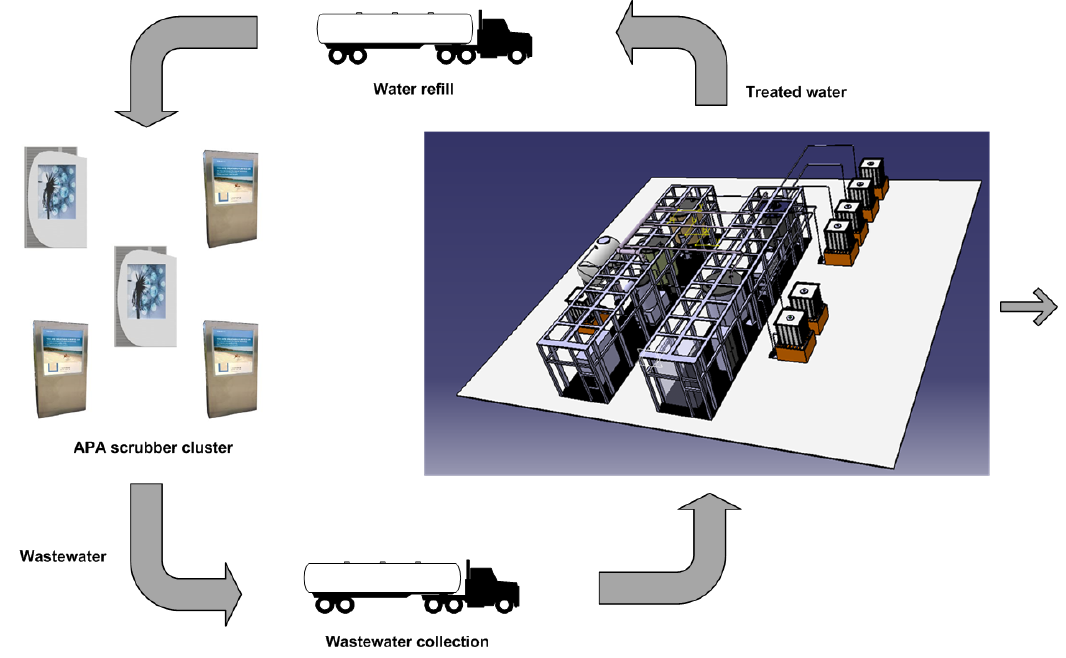
Figure 3. Water loop of the smart city pilot project.